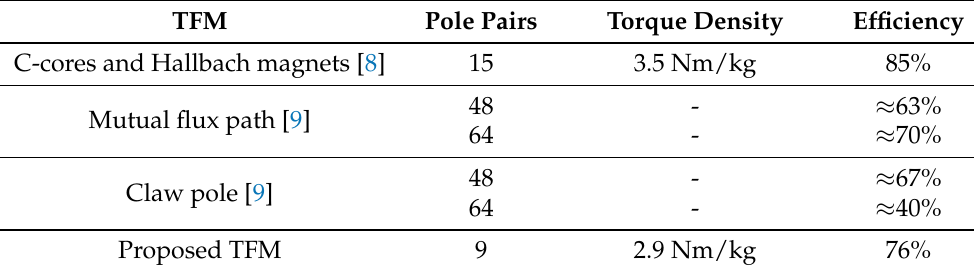
Table 7. Comparison between the proposed design and other TFMs.